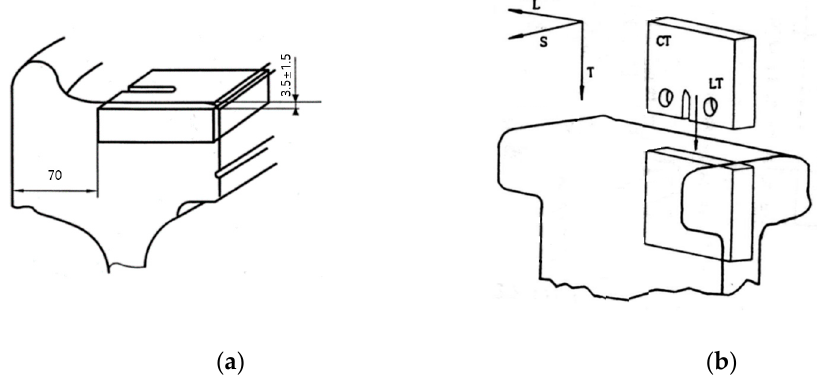
Figure 6. Orientation of fracture toughness and crack growth specimens: ( a ) wheel; ( b ) rail.